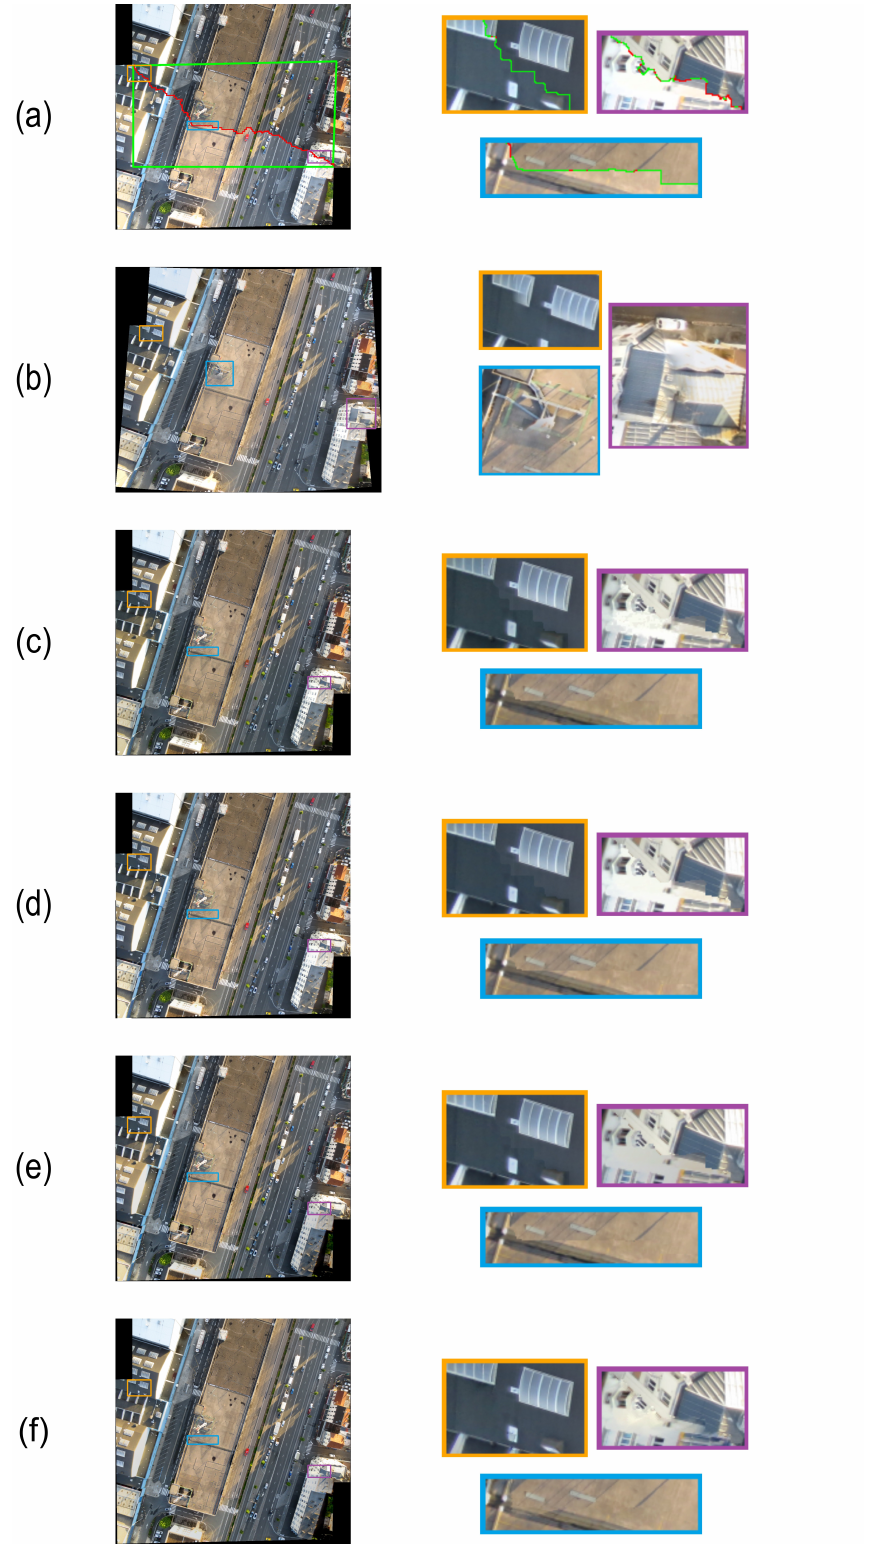
Figure 12. The perceptual quality merit of our method for the fifth testing stitched image taken from S 2 under +25% brightness update. ( a ) The testing stitched image and the amplified sub-images near the stitching line. ( b ) The MBB method [18]. ( c ) The HM-based method [19]. ( d ) The GP-based method [21]. ( e ) The GBJI-based method [23]. ( f ) Our